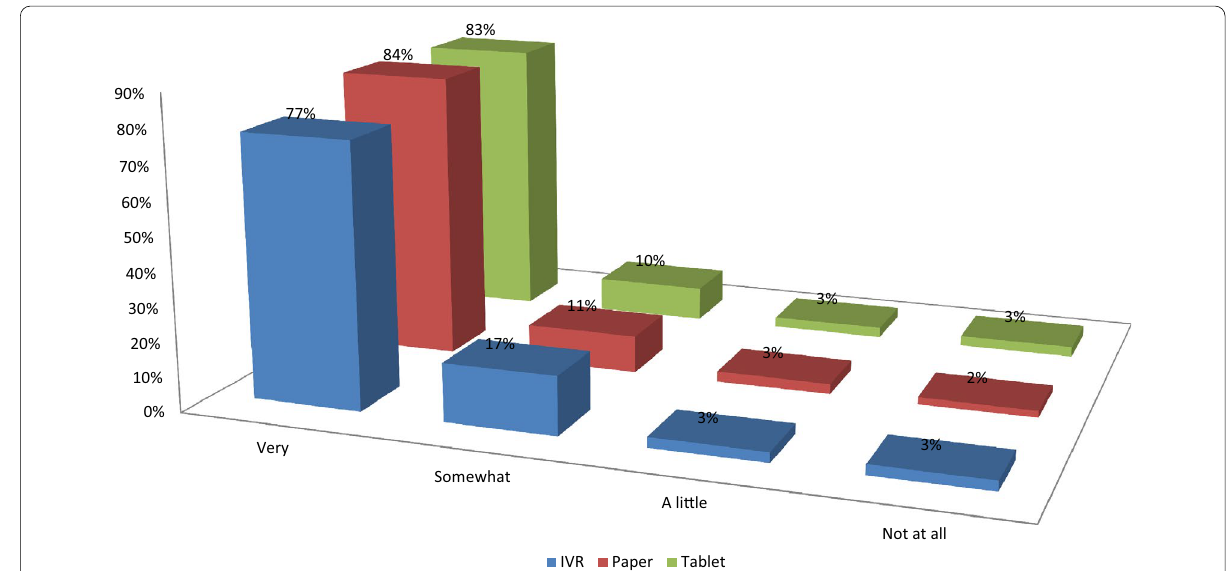
Fig. 3 How willing to use paper survey?